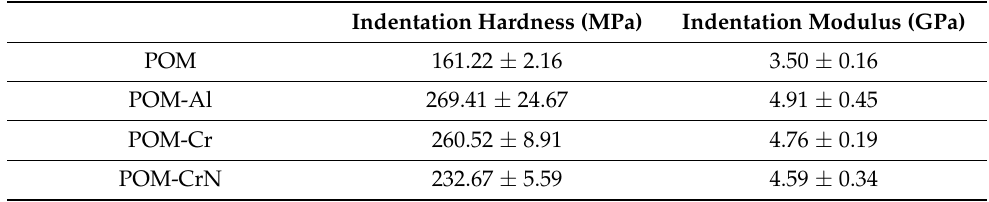
Table 3. Indentation hardness and modulus in the range between 10 and 100